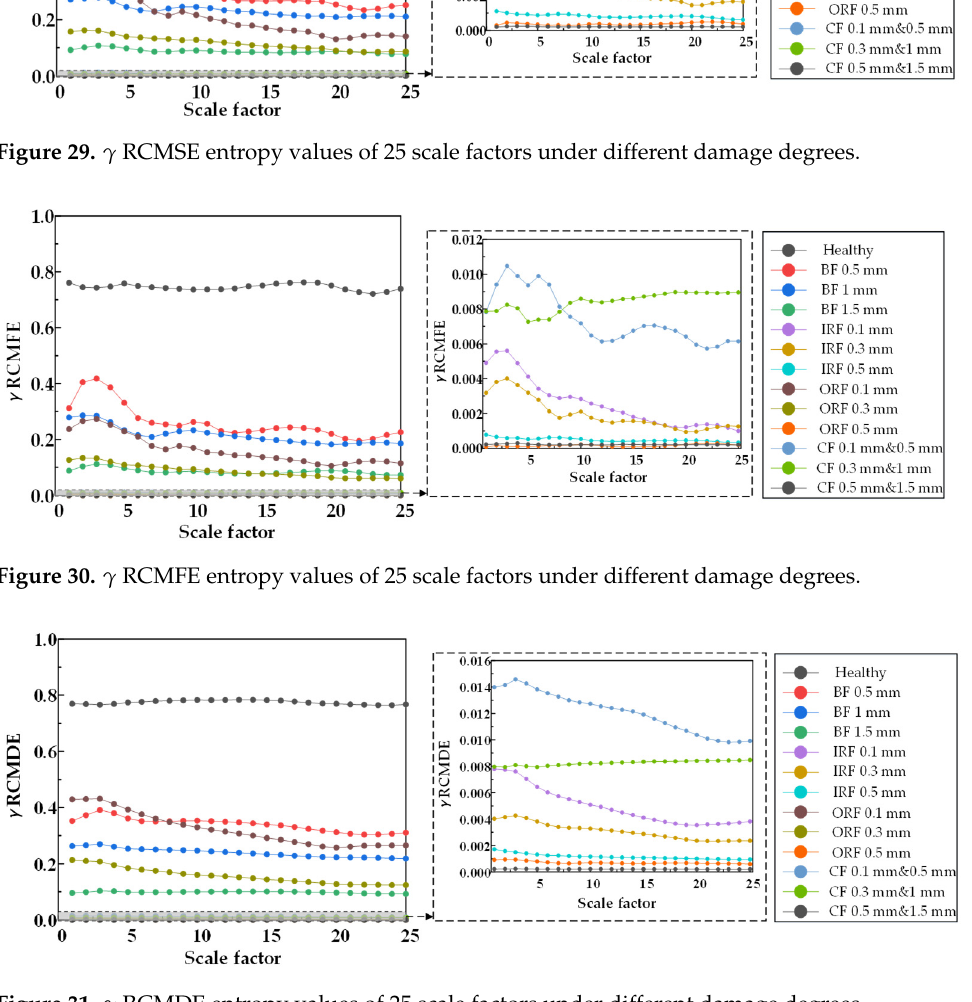
Figure 31. γ RCMDE entropy values of 25 scale factors under different damage degrees.